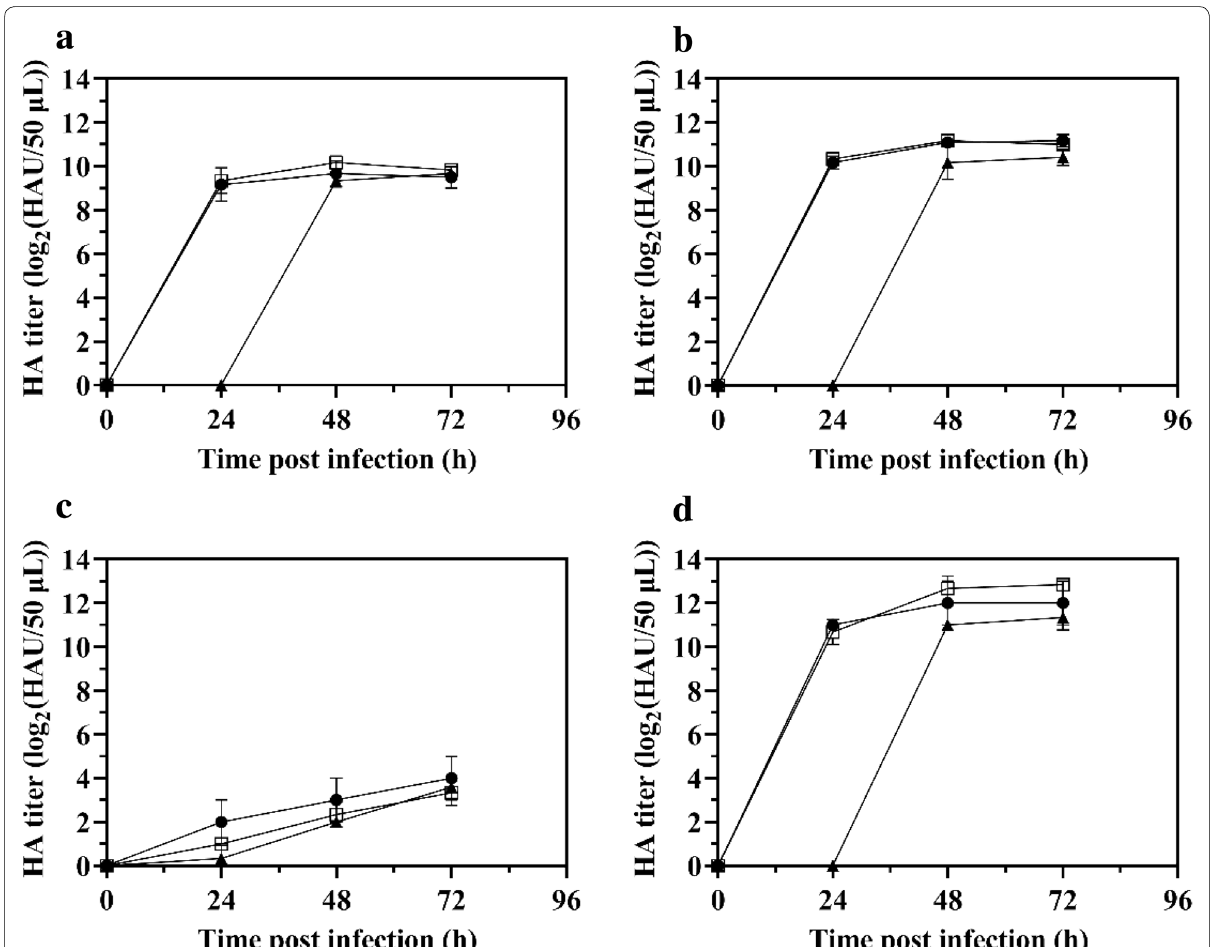
Fig. 3 Optimization of infection parameters for H9N2 production in Xeno serum‑free medium in shake flasks ( n different panels when cells were infected at cell concentration of 6 with a MOI of 10 − 2 (black circle), 10 − 3 (white square) and 10 − 4 (black triangle). a Cell concentration of 6 b Cell concentration of 6 10 6 cells/mL with medium exchange. c Cell concentration of 10 × concentration of 10 10 6 cells/mL with medium ×